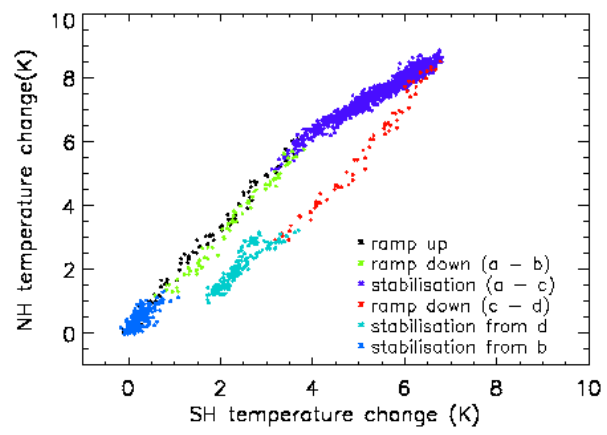
Figure 3. The sensitivity of Antarctic sea ice area change to a) global temperature